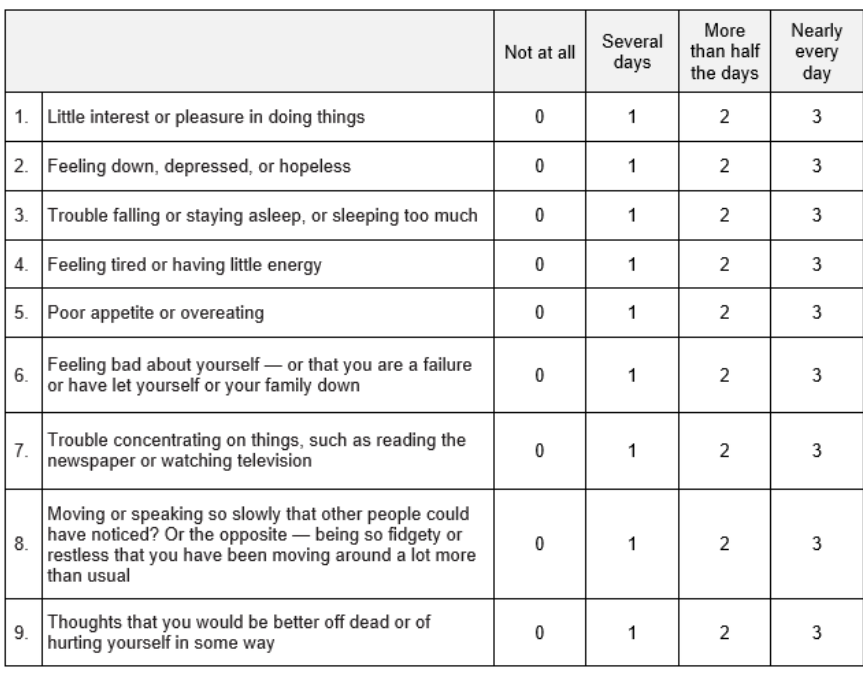
Figure A4. PHQ-9 Figure A4. PHQ-9 Questionnaire. Figure A4. PHQ-9 Questionnaire.